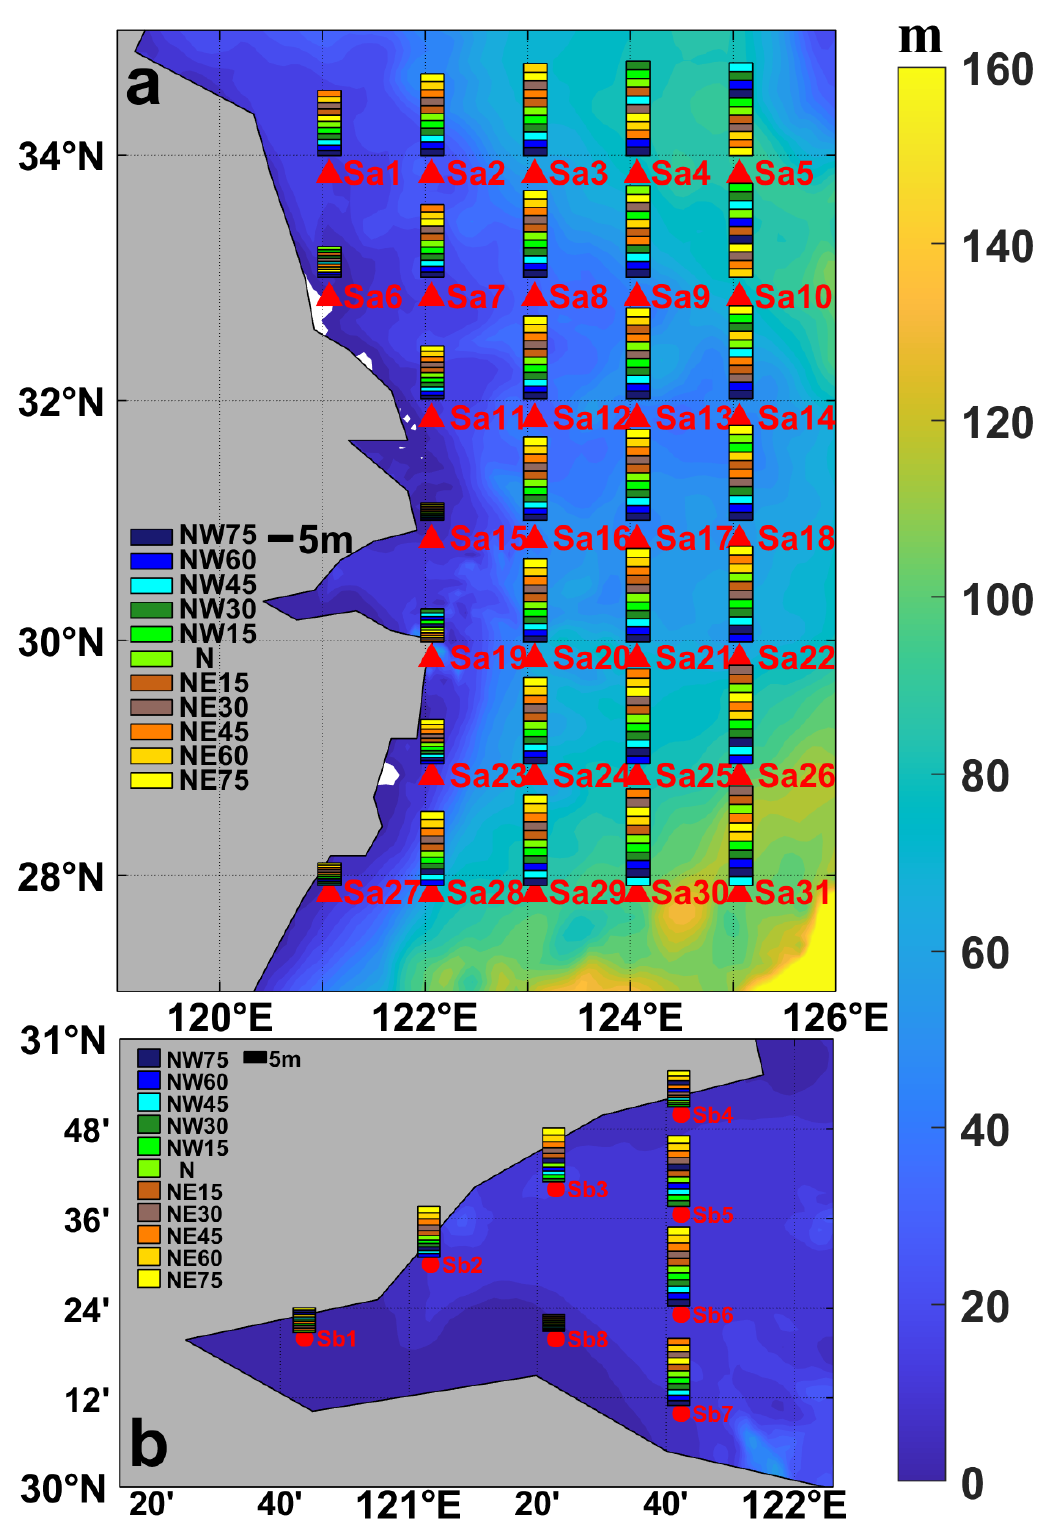
Figure 13. ( a ) The MSWH of Sa stations in offshore Zhejiang under the influence of cold fronts with different wind directions; ( b ) same; for Sb stations in Hangzhou Bay. The MSWH of each station in each experiment is arranged in ascending order (the larger MSWH is closer to the top of the respective histogram).